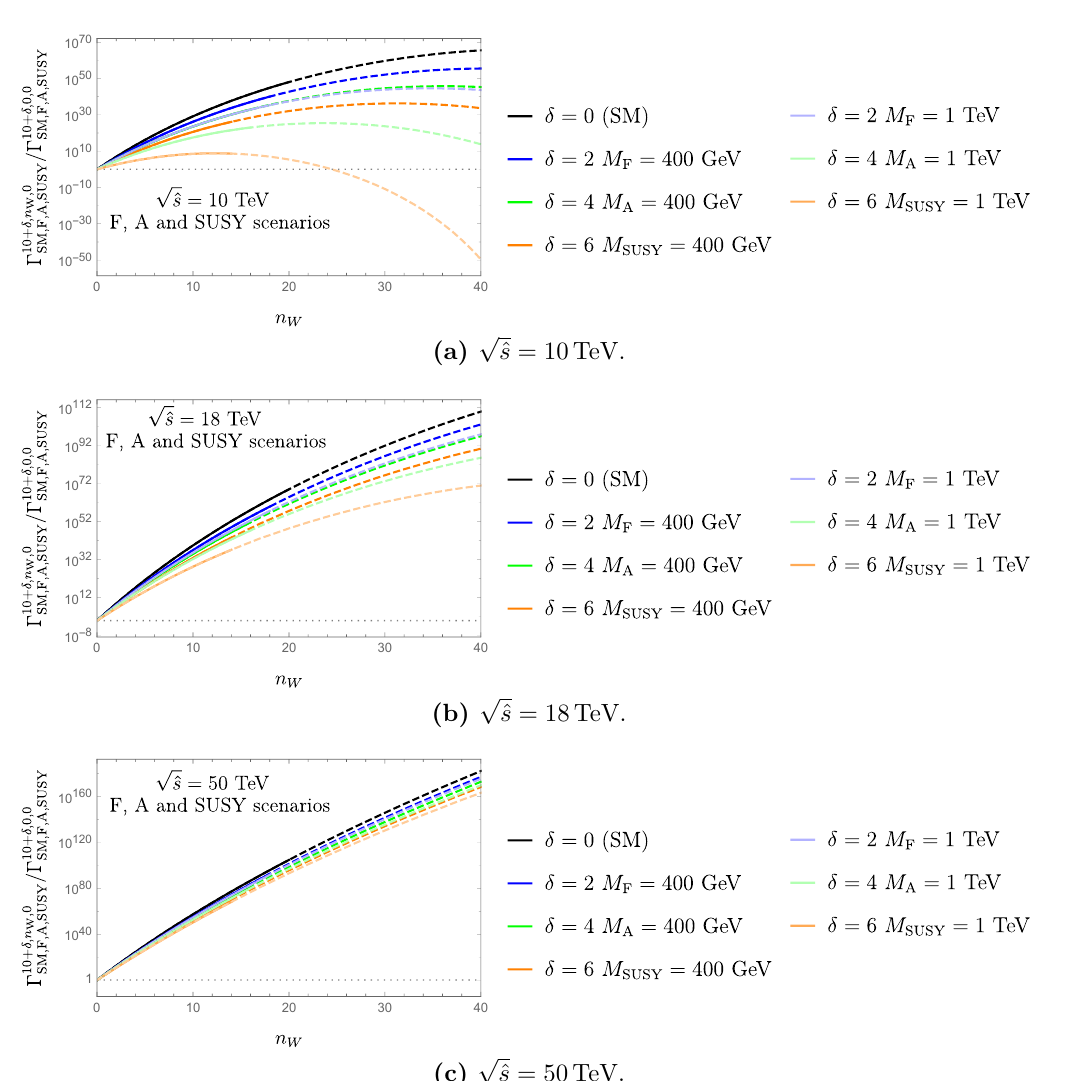
Figure 4. n W distributions for several qq collision energies